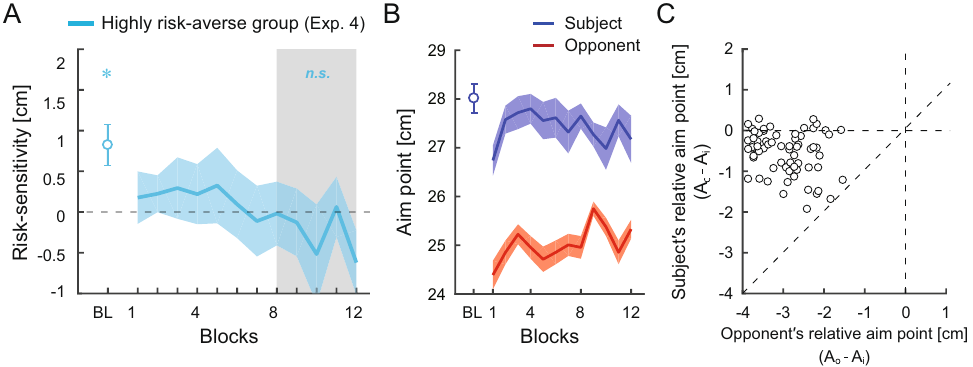
Figure 7. Competition with a highly risk-averse opponent in Experiment 4. ( A ) Risk-sensitivity value is plotted for the baseline and for each block of the competitive task. A positive value indicates a risk-seeking strategy. * denotes p < 0.05 from the risk-neutral value (i.e., 0). The sub-optimal risk-seeking strategy at the baseline improved during the competition. The shaded gray area denotes the last 50 trials of the competitive task. ( B ) Change of aim point (mean endpoint) when competing against the highly risk-averse opponent. The opponent aim point was set further away from the boundary line. We replicated the results in the risk-averse group (Fig. 3B). The subjects’ aim point decreased from the baseline and retained during the competition. Data is averaged across the subjects, and the shaded area denotes the standard error of the mean. ( C ) Aim point modulation as a non-linear function of the opponents’ relative aim point. The subjects’ relative aim point (mean endpoint in the competitive task A c - mean endpoint in the individual task A i ) is plotted against the opponents’ relative aim point (mean endpoint of the opponent A o − A i ). Sixty-six data points (11[2nd–12th] blocks × 6 subjects) are